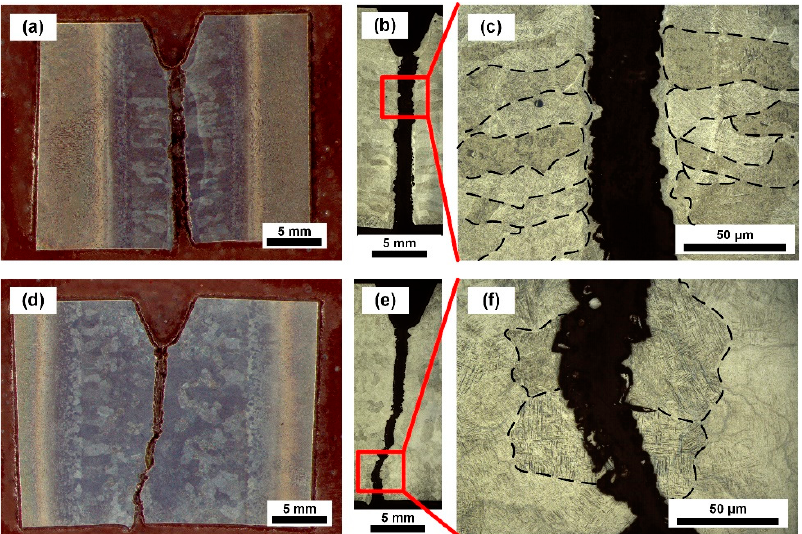
Figure 12. Fracture path of impact test. ( a ) The fracture path of 8-layer filled weld; ( b , c ) the microstructure characteristics around the fracture path of 8-layer filled weld; ( d ) the fracture path of 4-layer filled weld; ( e , f ) the microstructure characteristics around fracture path of 4-layer filled weld.